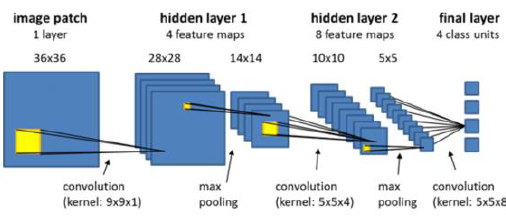
Figure 3 : A simple CNN model architecture (Trimble’s eCognition Developer,